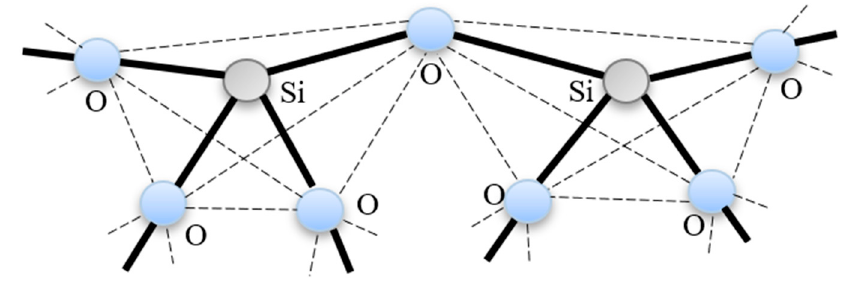
Figure 3. Silica structure; corner-sharing SiO 4